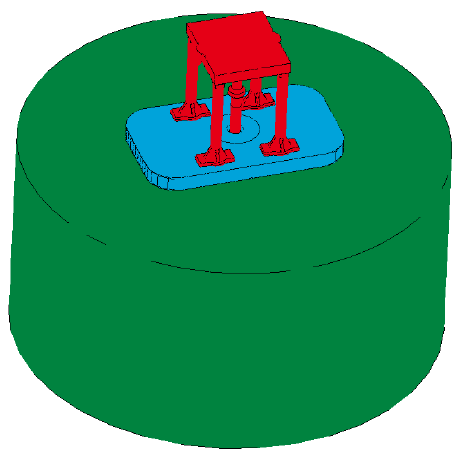
Figure 4. Vibrator geometric model.